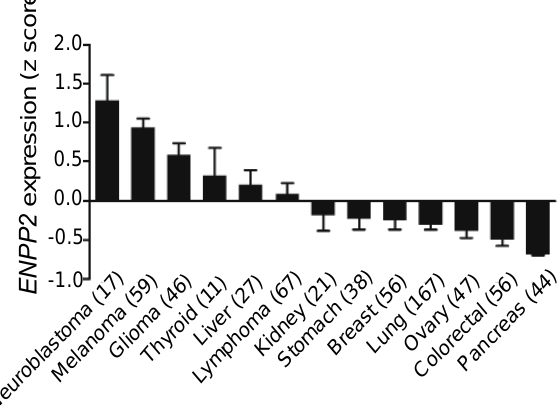
Figure 2. Overview of ATX mRNA expression across cell lines. Breast cancer cell lines express extremely low ATX mRNA relative to other cancer types. Numbers in parentheses indicate number of cell lines. Results from cBioPortal (www.cbioportal.org) [86,87].